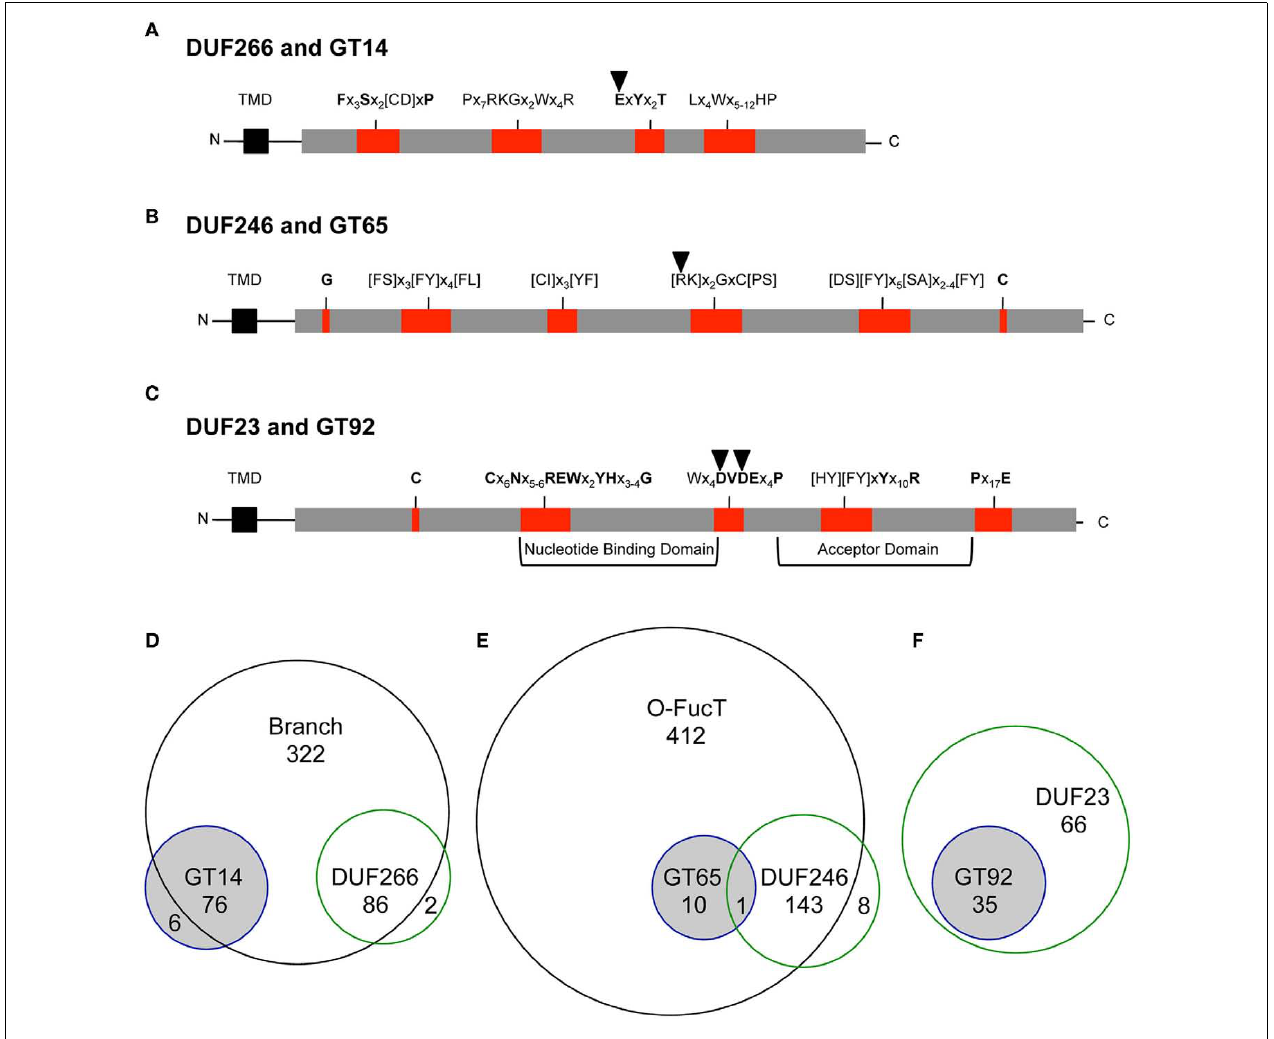
catalytic residues are marked with arrowheads. GT-A structure domains (Nucleotide Binding and Acceptor, respectively) are shown as Breton et al., 2006.TMD: transmembrane domain. (D–F) Illustration of the total number of plant UniProt sequences retrieved from (D) DUF266, GT14 and the Branch domain (PF02485), (E) DUF246, GT65, and the O -fucosyltransferase domain ( O -FucT; PF10250), and (F) GT92 and